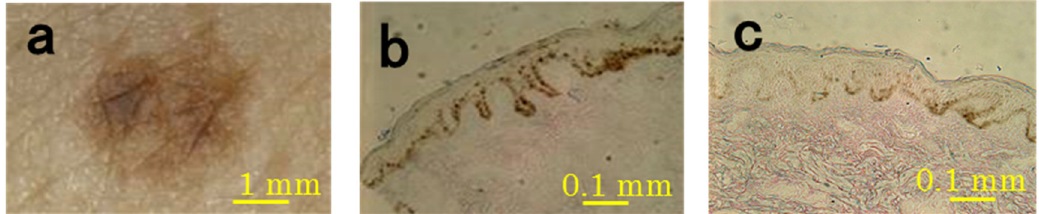
Figure 1. Representative microscopic features of SL lesions and perilesional normal skin (subject #4). The SL lesions were imaged with a video microscope ( a ) and sections were imaged with a light microscope (( b ) SL lesion; ( c ) perilesion).